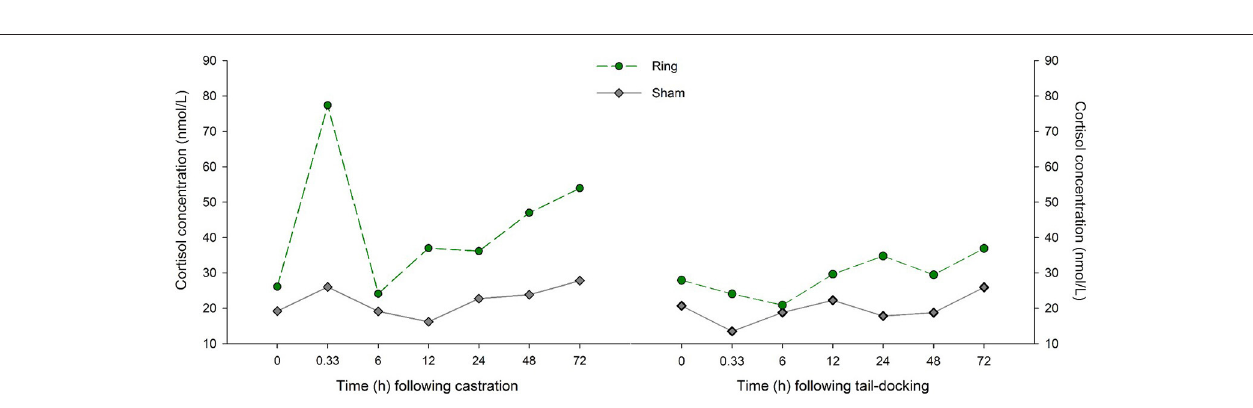
and a significant time effect ( P < 0.001). Thirty minutes following treatment, Ring lambs had an increase in cortisol concentration (transformed mean = 3.5, back transformed = 12.25 nmol/L, P < 0.001) compared to baseline. Ring lambs had higher cortisol concentrations at 30 min compared to Sham lambs (transformed mean = 8.3 back transformed = 68.89 vs. transformed mean = 7.25 back transformed = 56.64 nmol/L, respectively, P < 0.001). At 6, 12, 24 h, Ring lambs’ cortisol concentrations returned to higher than baseline concentrations at 48 h ( P = 0.02) and 72 h ( P = 0.001). Sham lambs experienced no change in cortisol concentration ( Figure 3 ).